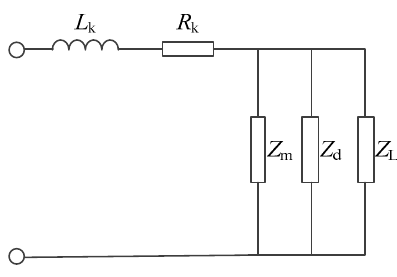
Figure 5. Circuit model of the electromagnetic unit.